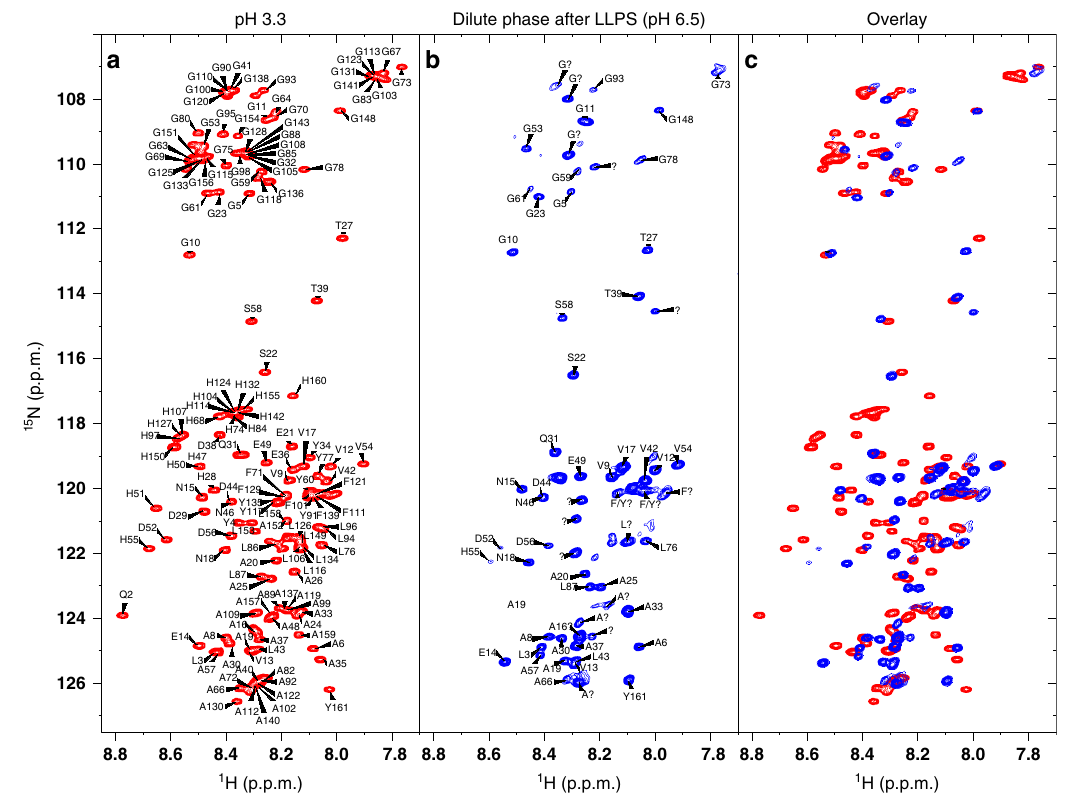
Fig. 1 1 H- 15 N-HSQC spectra of HBP-1 at different pH values. a HBP-1 in the initial solution state at pH 3.3. b Dilute phase after LLPS at pH 6.5 (after sedimentation of coacervate microdroplets). c Overlay of the two spectra. Spectra acquired at 298 K and a protein concentration of 2 mg mL − 1 (130 μ